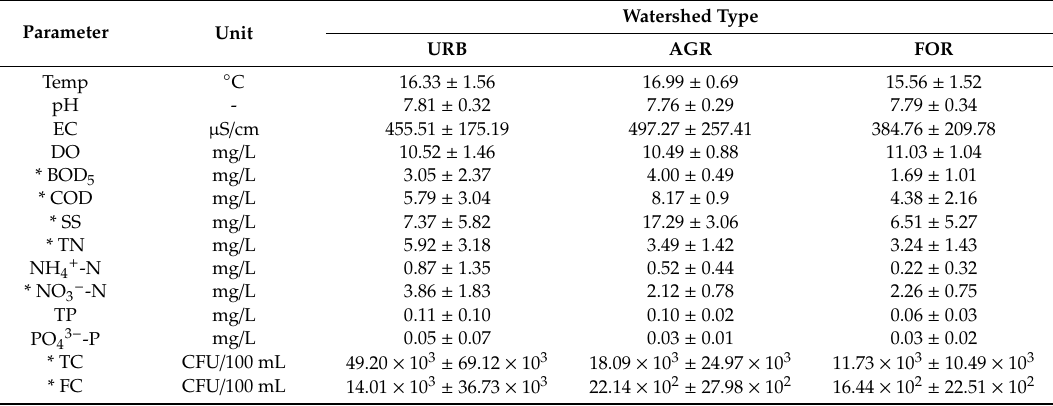
Table 2. Summary statistics (mean ± one standard deviation) of 14 water quality parameters from 2015 to 2018 forwatersheds withurban-dominated (URB),agricultural-dominated (AGR), andforest-dominated (FOR) land-cover. Asterisks (*) denote parameters whose mean value for either URB or AGR is significantly higher (or lower in the case of DO) than the other ( p -value < 0.05 based on Kruskal Wallis H and Mann-Whitney U